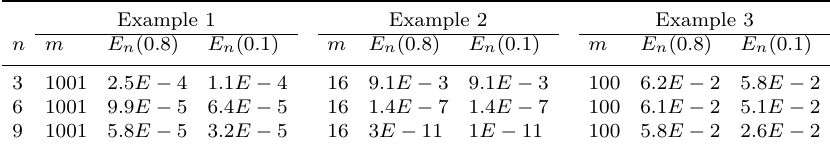
Table 3. Numerical results for Examples 1–3 with noise level 0 . 1%.